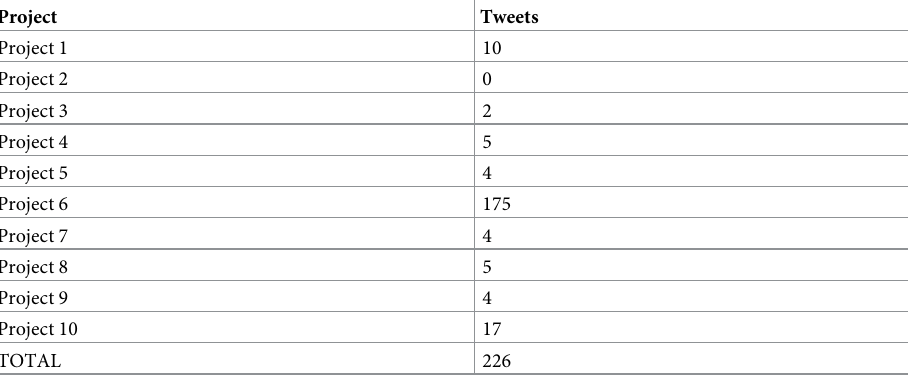
Table 4. Tweets obtained per project–Strategy 2.